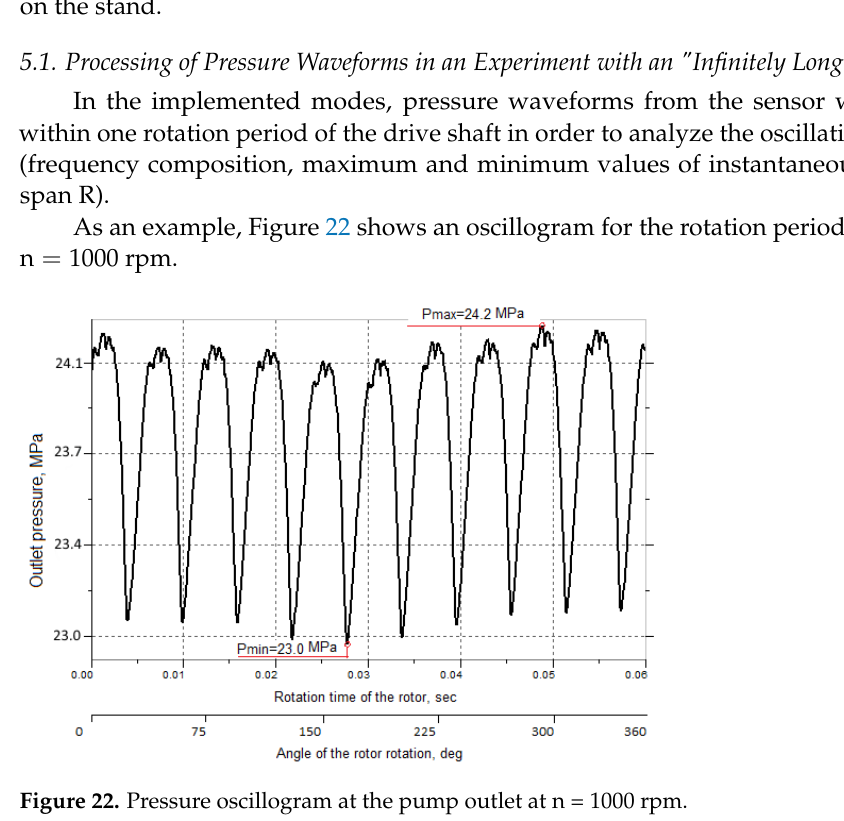
Figure 22. Pressure oscillogram at the pump outlet at n = 1000